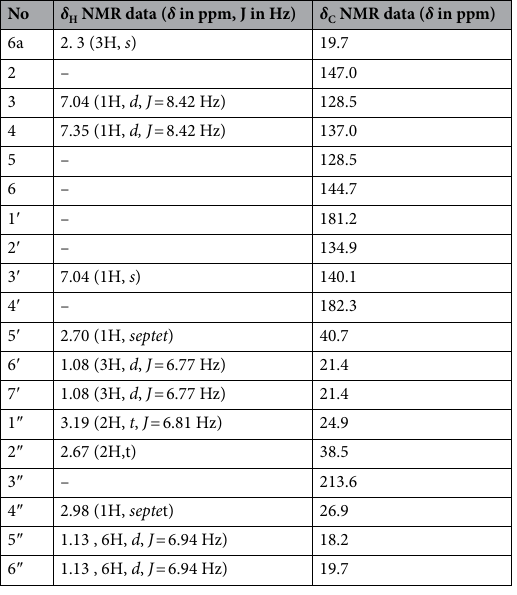
Table 1. 1 H (400 MHz, CDCl 3 ) and 13 C NMR (100 MHz, CDCl 3 ) data of compounds 3. δ in ppm and J in